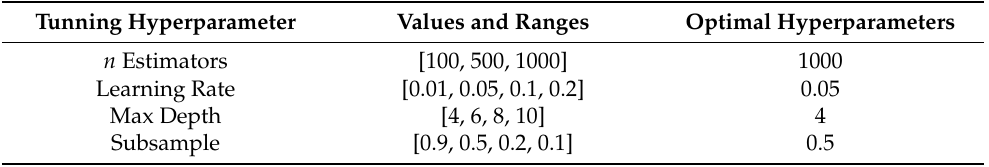
Table 3. Hyperparameters for the GBRT model.